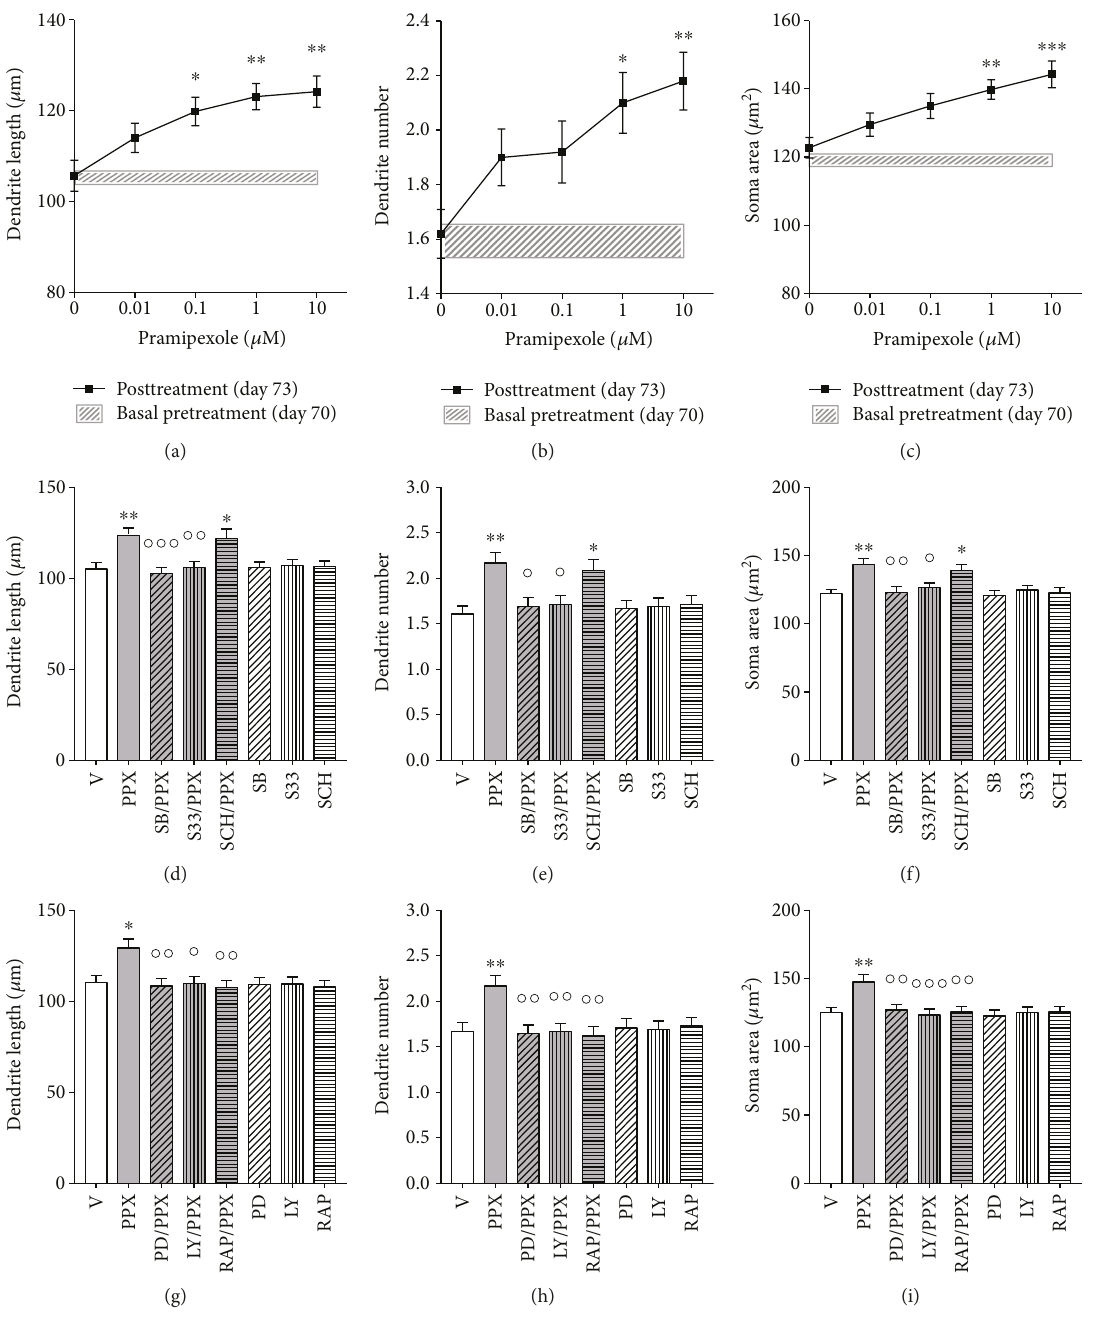
Figure 5: Structural plasticity induced by pramipexole in human iPSC-derived DA neurons is prevented by D3R antagonists and by MEK- ERK and PI3K-mTOR inhibitors. (a – c) Concentration-response curves of pramipexole e ff ects on (a) maximal length of dendrites, (b) number of primary dendrites, and (c) soma area of human F3 DA neurons. Shaded areas (a – c), light grey, show no signi fi cant changes in structural plasticity between basal measurements and measurements after 72 hrs when cultures were exposed to vehicle. Data are expressed as mean ± SEM ( ∗∗∗ p < 0 001 , ∗∗ p < 0 01 , and ∗ p < 0 05 versus vehicle (0); post hoc Bonferroni ’ s test). (d – f) Inhibition of the e ff ects of pramipexole (10 μ M) on structural plasticity following pretreatment (20 min) with either SB277011-A (50 nM) or S33084 (10 nM); (d) maximal dendrite length, (e) number of primary dendrites, and (f) soma area after 72 hrs. Pretreatment (20 min) with SCH23390 (1 μ M) was ine ff ective. (g – i) Inhibition of the e ff ects of pramipexole (10 μ M) on structural plasticity following pretreatment (20 min) with PD98059 (10 μ M), LY294002 (10 μ M), or rapamycin (20 nM); (g) maximal dendrite length, (h) number of primary dendrites, and (i) soma area after 72 hrs. No changes of structural plasticity were visualized when antagonists and inhibitors were tested with the vehicle. Data are expressed as mean ± SEM ( ∗∗∗ p < 0 001 , ∗∗ p < 0 01 , and ∗ p < 0 05 versus vehicle; °°° p < 0 001 , °° p < 0 01 , and ° p < 0 05 versus pramipexole; post hoc Bonferroni ’ s test). V, vehicle; PPX, pramipexole; SB, SB277011-A; S33, S33084; SCH, SCH23390; PD, PD98059; LY, LY294002; RAP,